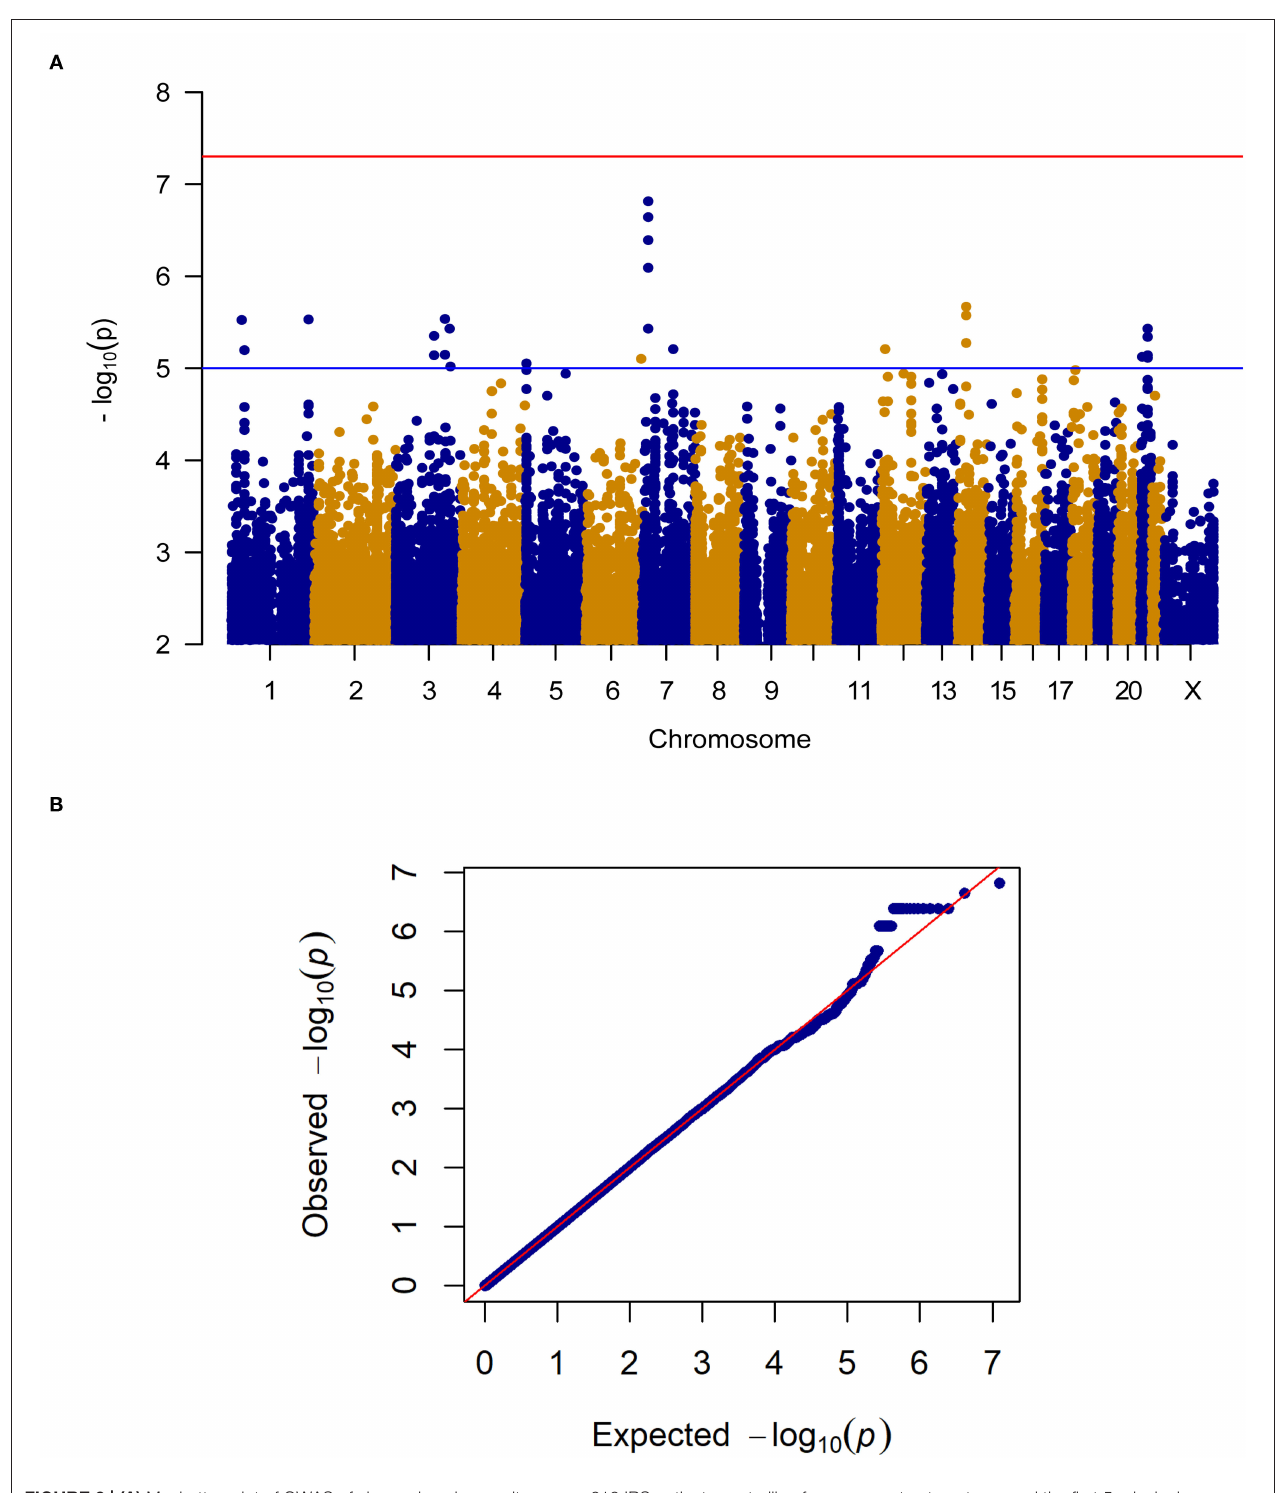
FIGURE 2 | (A) Manhattan plot of GWAS of change in pain severity among 212 IBS patients controlling for age, sex, treatment arm and the first 5 principal components for genetic ancestry. The x-axis is chromosome position and the y-axis is p -value. The red line represents the “genome-wide significant” threshold, 5.0E-8, and the blue line denotes the “genome-wide suggestive” threshold, 1.0E-5. We did not find genome-wide significant SNPs for change in pain severity, but we did find a few genome-wide suggestive SNPs. (B) Quantile-quantile plot of the data. The genomic inflation factor λ is 0.994, which indicates that no inflation of data was observed in the GWAS of change in pain severity from baseline to 6 weeks across all treatment arms.